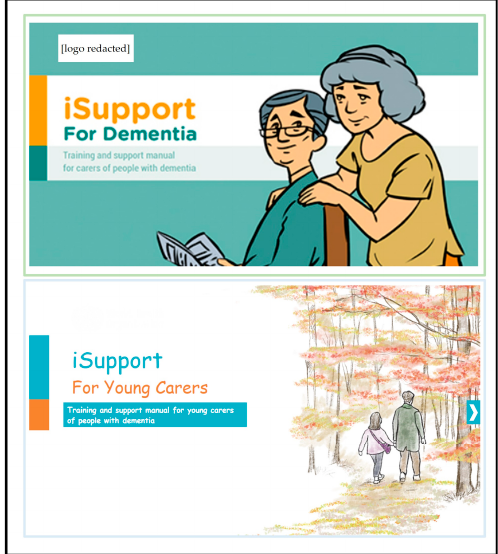
Figure 6. iSupport cover before and after the